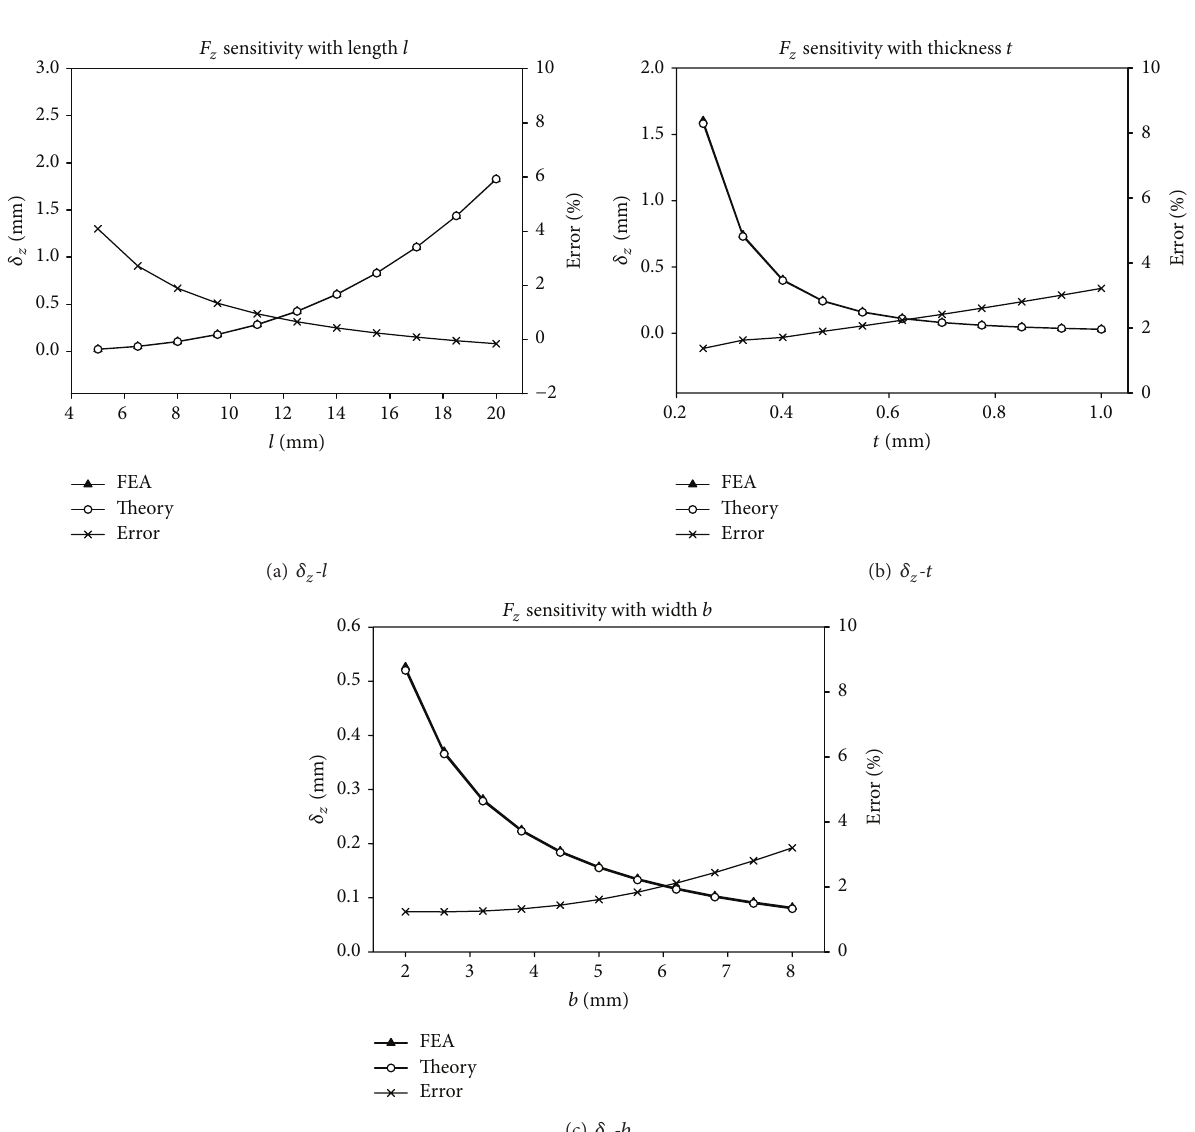
applied to the SBLF are 𝐹 𝑥 = 10 N, 𝐹 𝑦 = 𝐹 𝑧 = 1 N, and 𝑇 𝑥 = = 𝑀 = 1 Nmm. The warping restraint factor was 𝑀 𝑦 𝑧